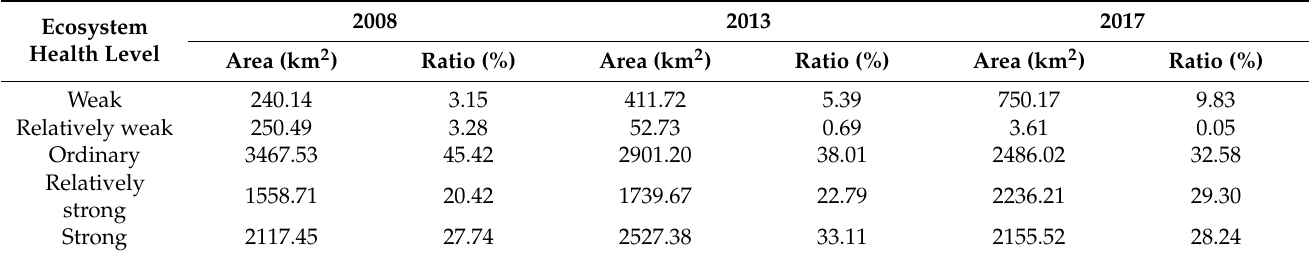
Table 4. Area and ratio of different ecosystem health classes in 2008, 2013, and